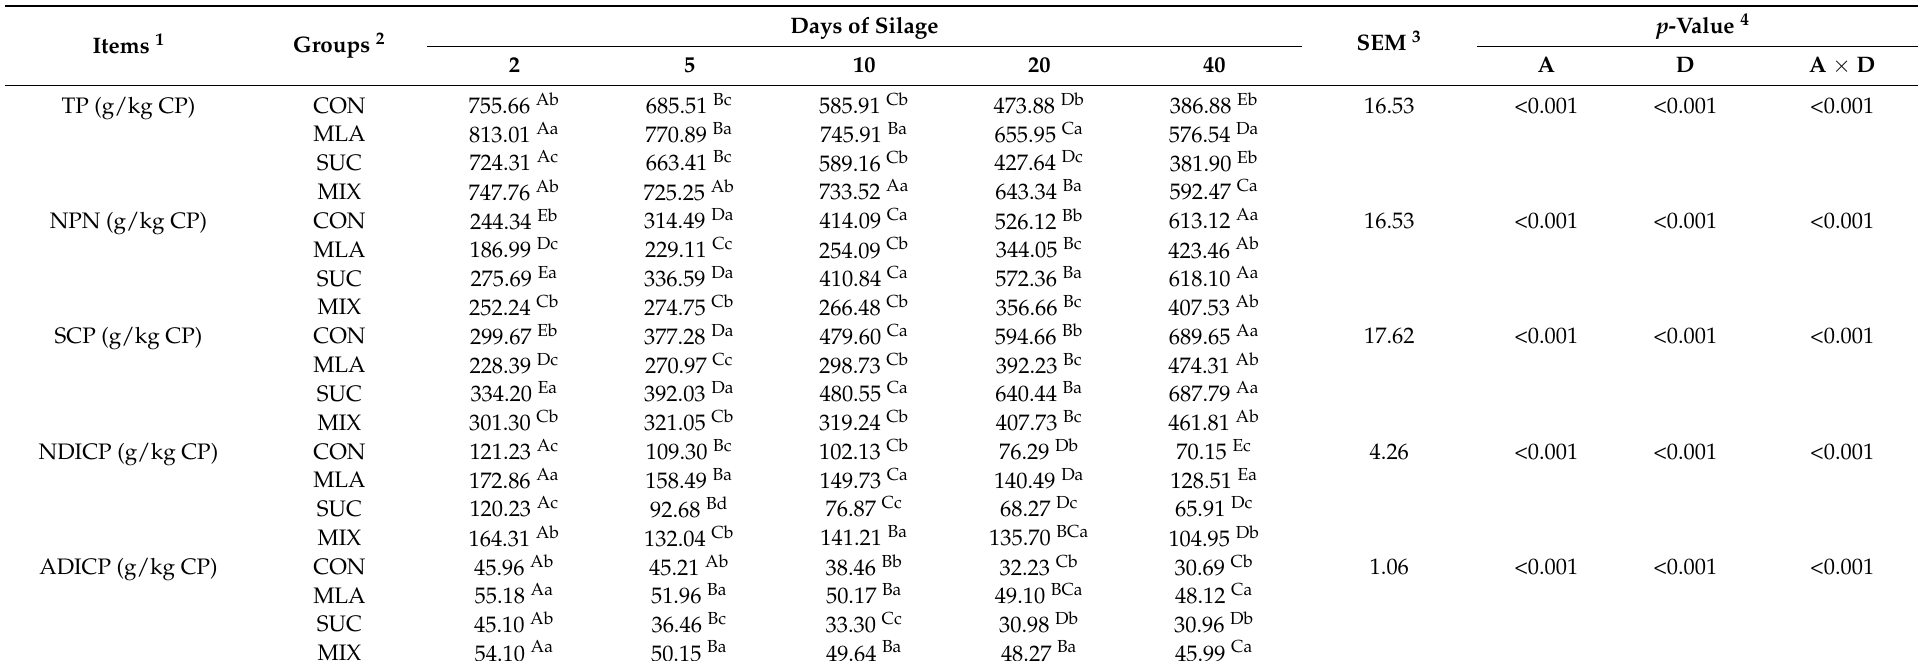
Table 3. Nitrogen fractions of ensiled Moringa oleifera leaves treated with malic acid and